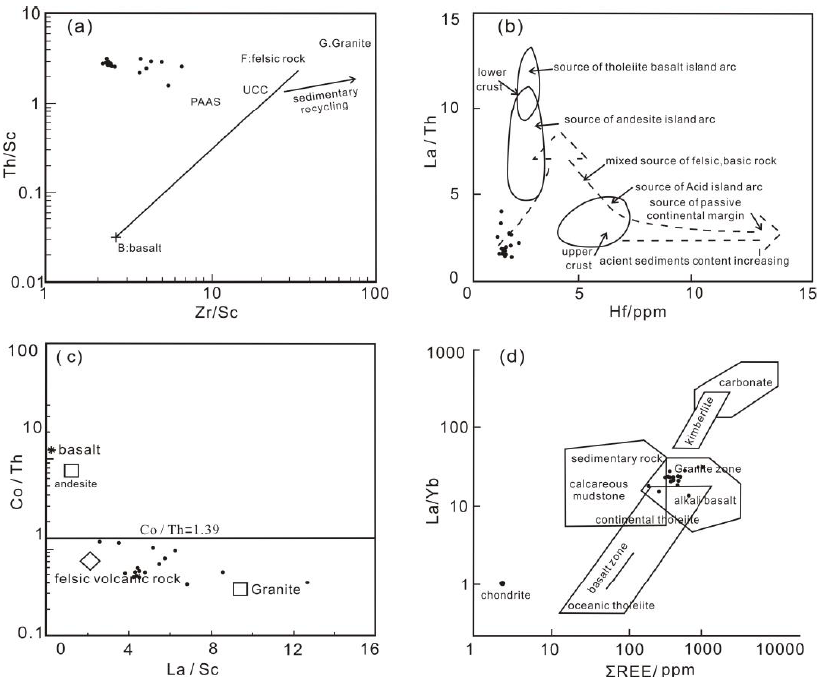
Figure 11. Kinds of discrimination diagrams reflect the parent rock type. The templates are from ( a ) Mclennan et al., 1993; ( b ) Floyd and Leveridge, 1987; ( c ) Wronkiewicz and Condie, 1987; and ( d ) Allegre and Minster, 1978.